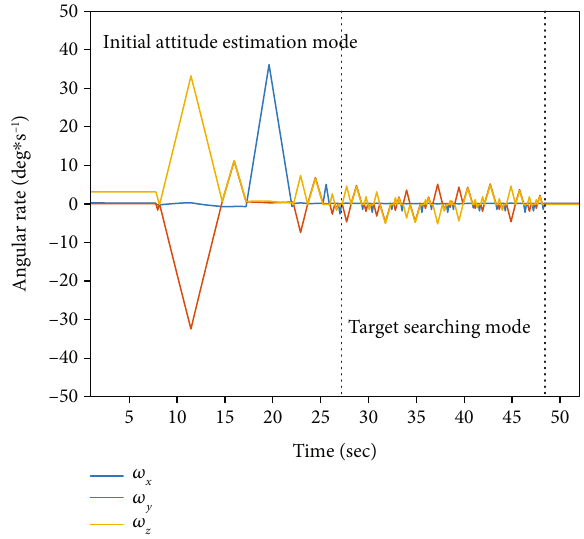
Figure 10: Time history of angular rate during initial attitude estimation mode and target searching